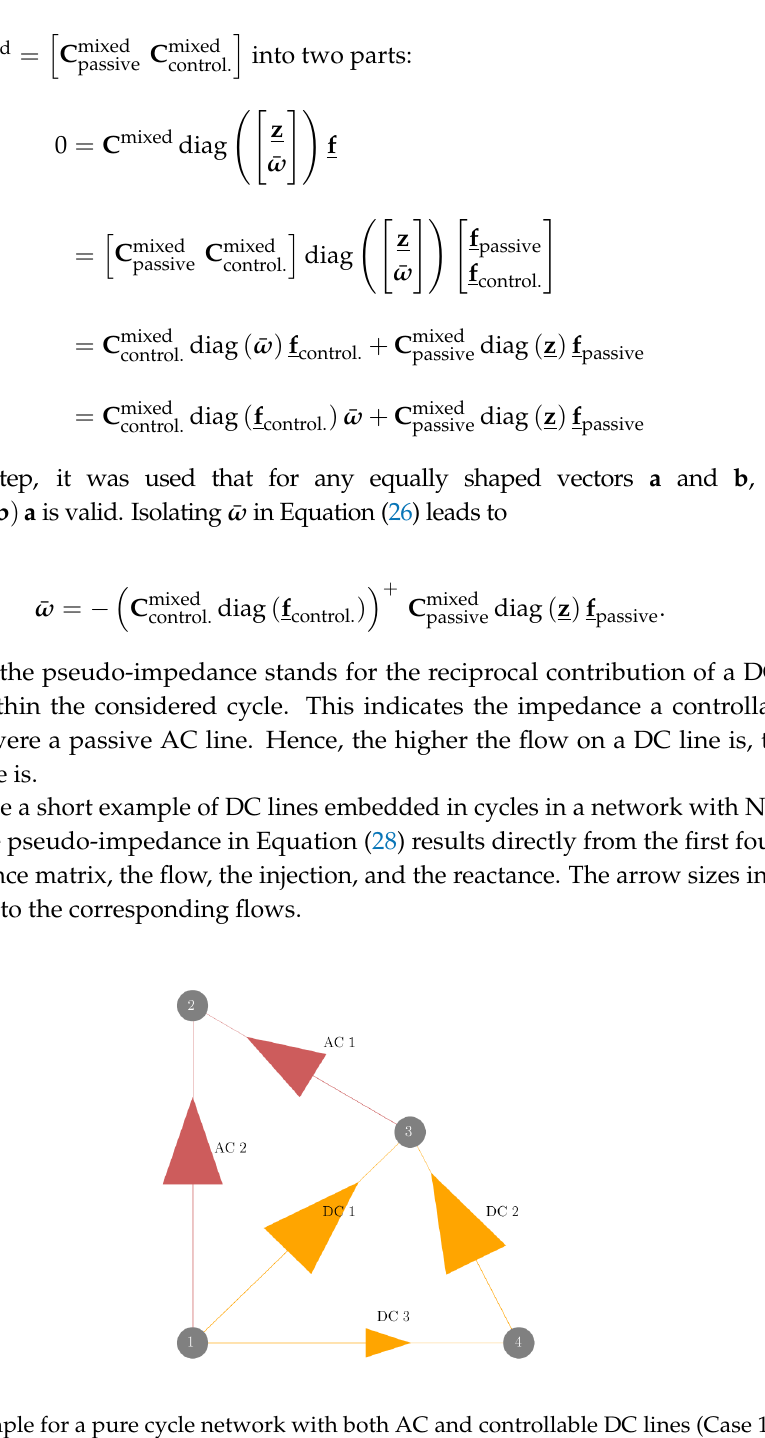
Figure 1. Example for a pure cycle network with both AC and controllable DC lines (Case 1). When creating a PTDF matrix for such a flow pattern the pseudo-impedance values for the DC lines are given by Equation (27). Relevant corresponding network quantities are given in Equation